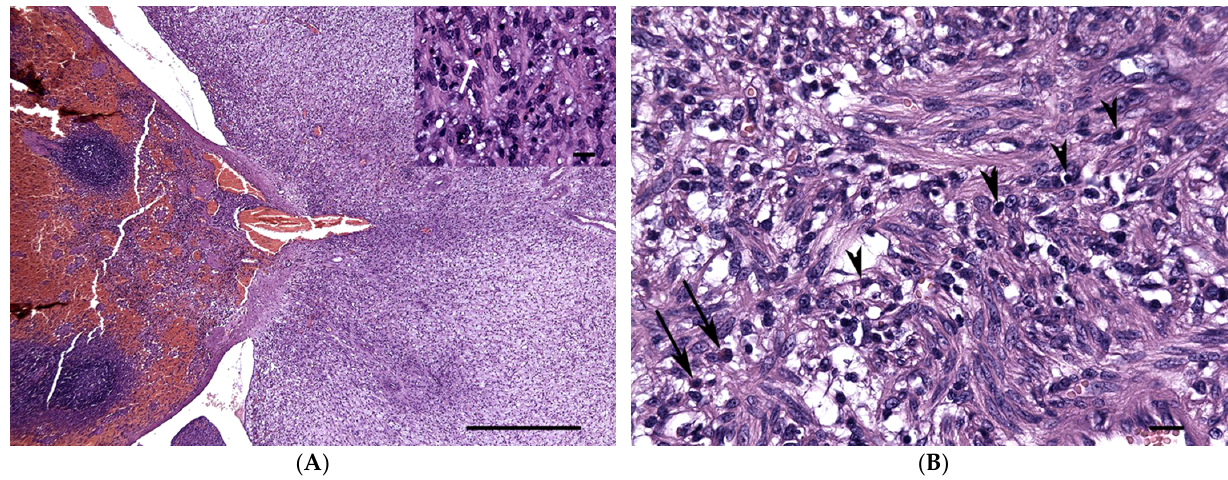
Figure 2. Inflammatory myofibroblastic tumor, spleen, cat. Hematoxylin Eosin. ( A ) On the right side of the image there is a portion of the mass merging from the splenic capsule. Normal splenic parenchyma on the left. Bar = 2.5 mm; magnification 5 × . Inset: Higher magnification of the mass composed of mesenchymal spindle cells mixed with few inflammatory cells including some eosinophils (white arrow). Bar = 30 µ m, magnification 20 × . ( B ) Closer view showing mesenchymal spindle cells embedded in loose fibrillar eosinophilic matrix and organized in small irregular bundles. Disseminated inflammatory cells are also present, as lymphocytes (arrowheads) and eosinophils (black arrows). Bar = 50 µ m, magnification 20 ×